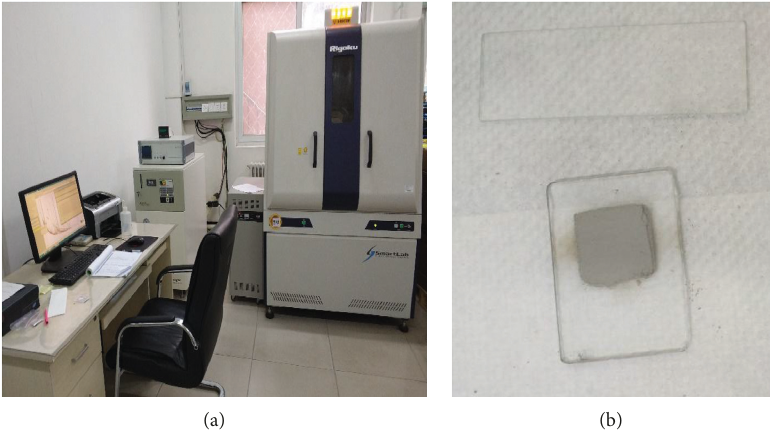
Figure 2: The Empyrean Diffractometer and sample. (a) The X-ray diffraction (XRD) analyzer; (b) the sample.